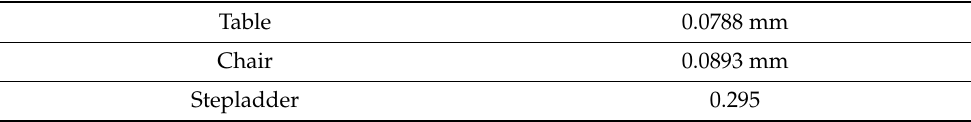
Table 10. Results of maximum deformations.